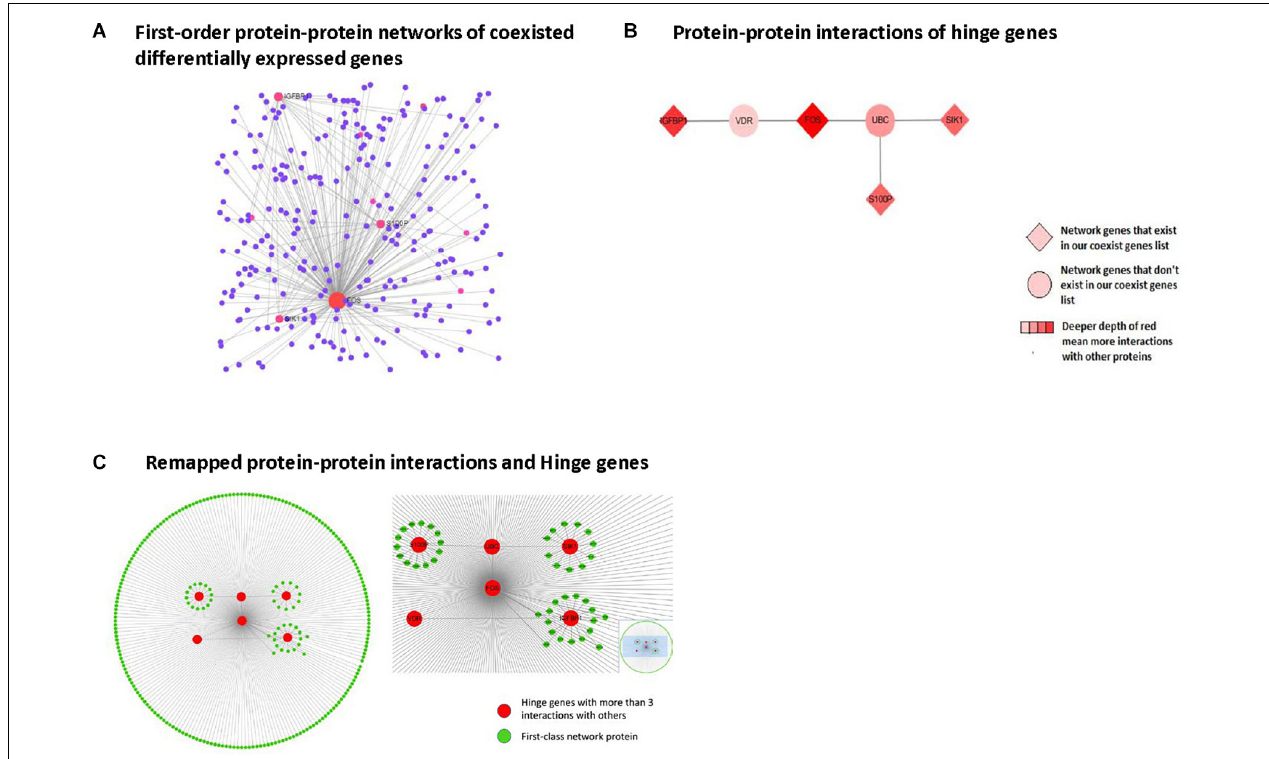
FIGURE 5 | Protein-protein interaction network analysis in first-order networks and network hinge genes identifying. (A) Displays first order protein-protein interaction networks of coexisting DEGs, red spot means protein with more than three interactions with others. (B) Displays remapped protein-protein interactions and Hinge genes. (C) Displays protein-protein interaction of hinge